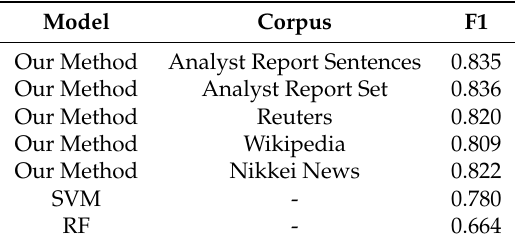
Table 3. Results of opinion sentence extraction (pre-experiment). The evaluation index is